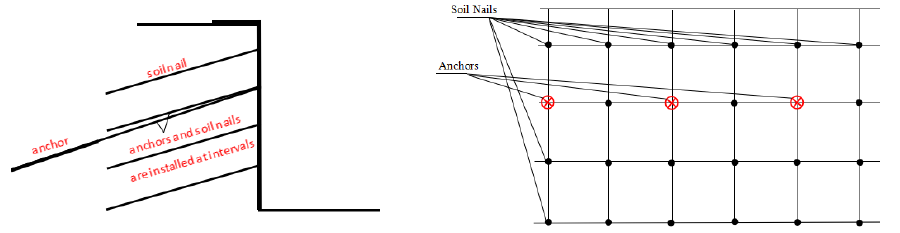
Figure 1. Vertical section of soil nail–prestressed anchor composite retaining structure.